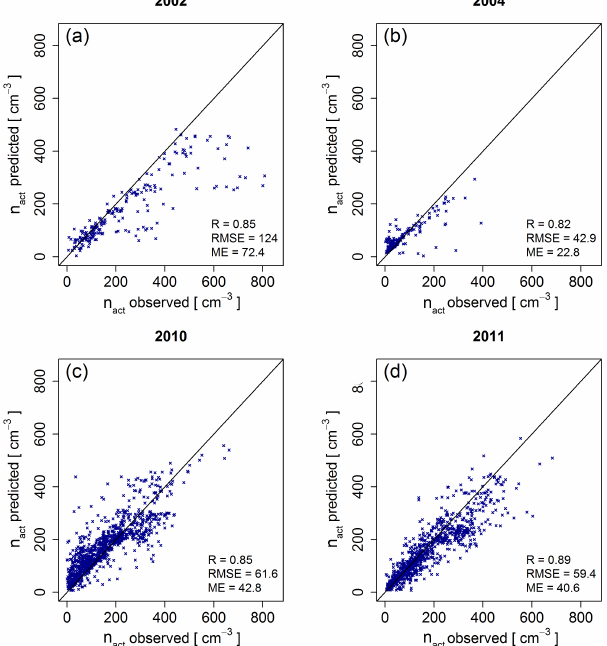
Figure 11. The number of cloud droplets calculated by the micro- physical parametrization, separated by year, compared to the num- ber of observed cloud droplet